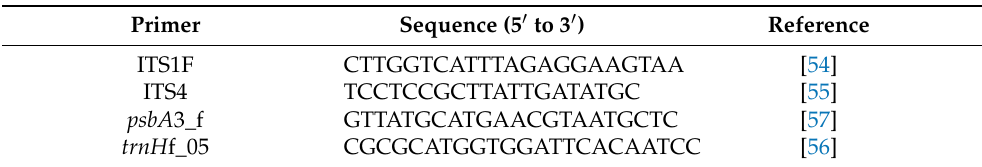
Table 1. Primers used for amplification and Sanger sequencing of the ITS rDNA region and trnH - psbA intergenic